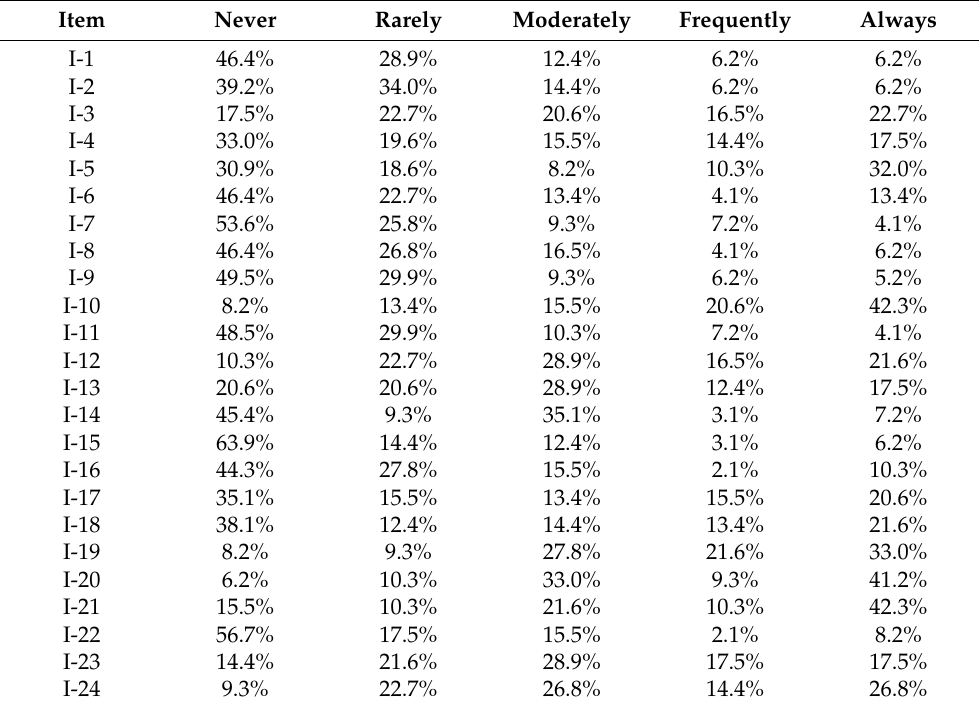
Table 5. Results of descriptive